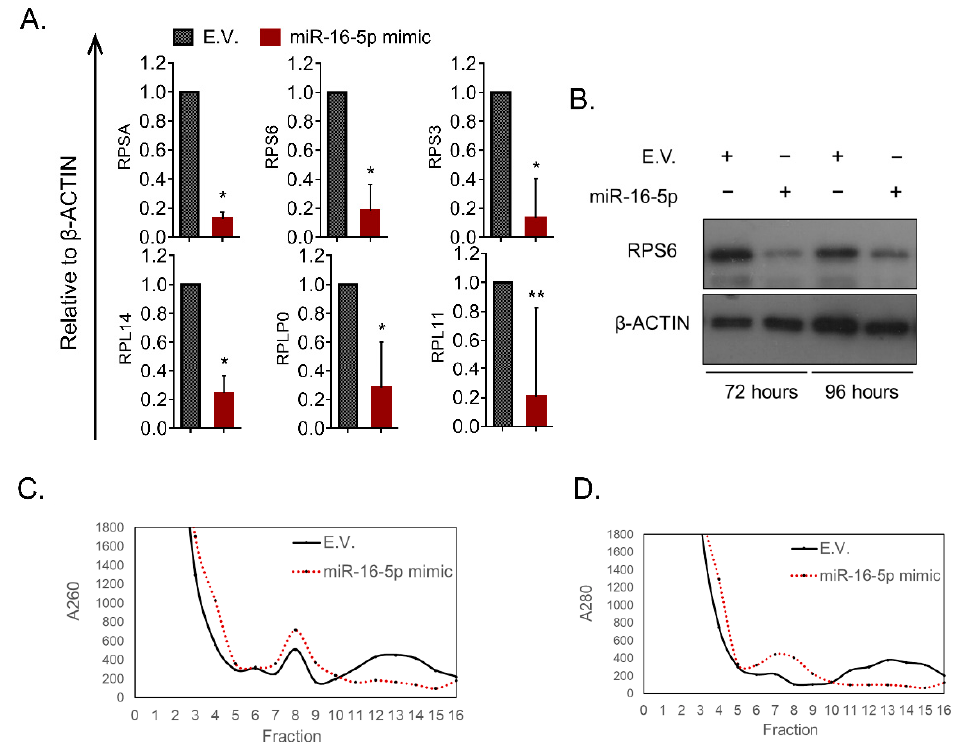
Figure 5. miR-16-5p overexpression modulates ribosomes in MEL cells. ( A ) mRNA levels of selected members of the small and large subunit of the ribosome in E.V. against miR-16-5p mimic treated cells. All genes were normalized to β -actin expression. Statistical significance was inferred using a two-tailed t -test between E.V. and miR-16-5p mimic treated cells. * p < 0.001, ** p < 0.05. ( B ) Protein levels of RPS6 after 72 and 96 h of treatment with either E.V. or miR-16-5p mimic plasmid. ( C ) Ribosome fractionation through ultracentrifugation in a sucrose gradient, derived from cells treated with E.V. or miR-16-5p. After the ultracentrifugation the gradient was separated into 16 fractions and absorbance at 260 nm was determined using a spectrophotometer. Fractions 7-8 correspond to monosomal particles and fractions 10–16 are mainly populated by polysomes. ( D ) Same as with C but here absorbance at 280 nm was determined.